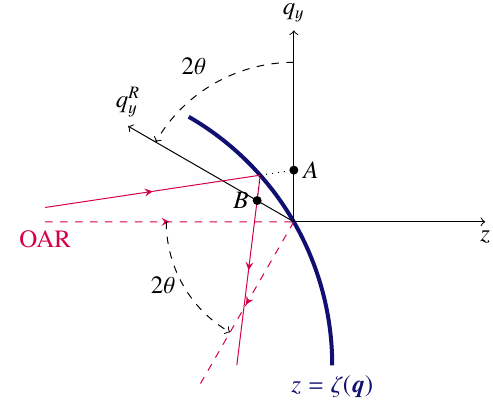
Figure 1. The reflection operator maps the point A of the incom- ing ray to the point B of the outgoing ray in the rotated coordinate system. The OAR (dashed) is mapped from the origin to itself. The incidence angle of the OAR on the reflector is equal to θ